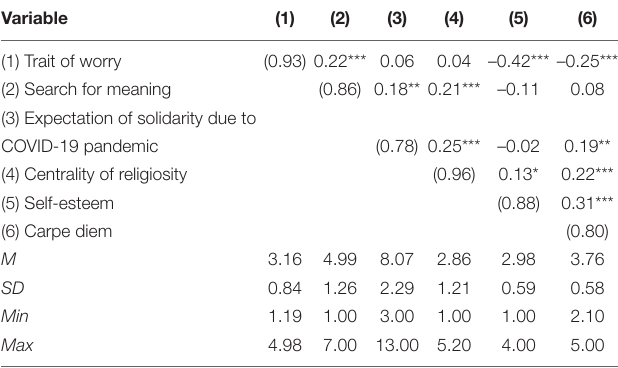
TABLE 1 | Bivariate scale intercorrelations and descriptive statistics.